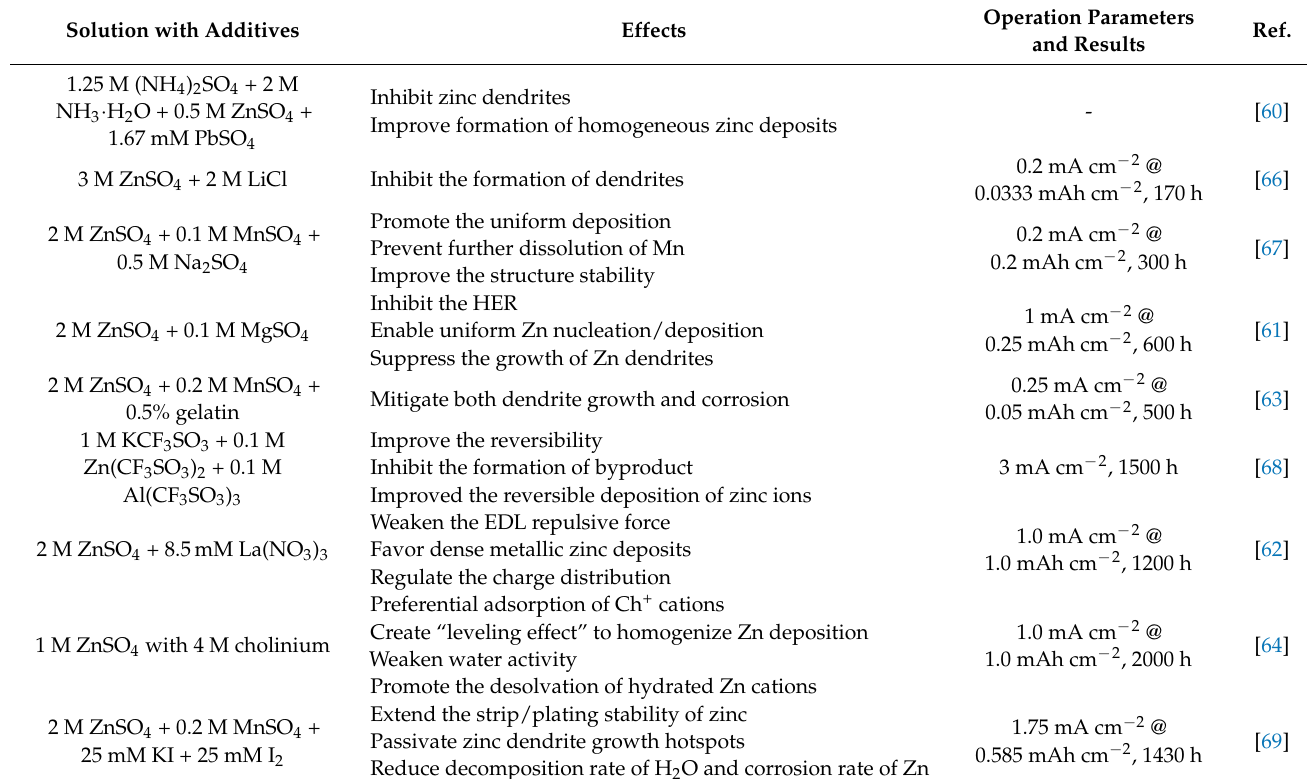
Table 1. Ionic additives and effects in